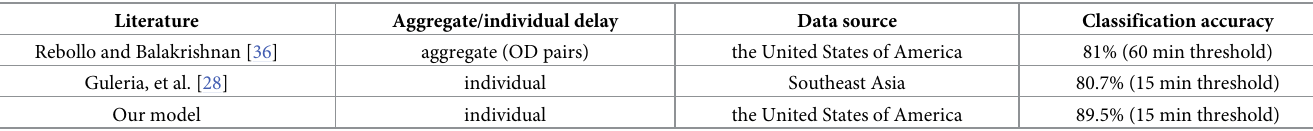
Table 4. The performance of existing